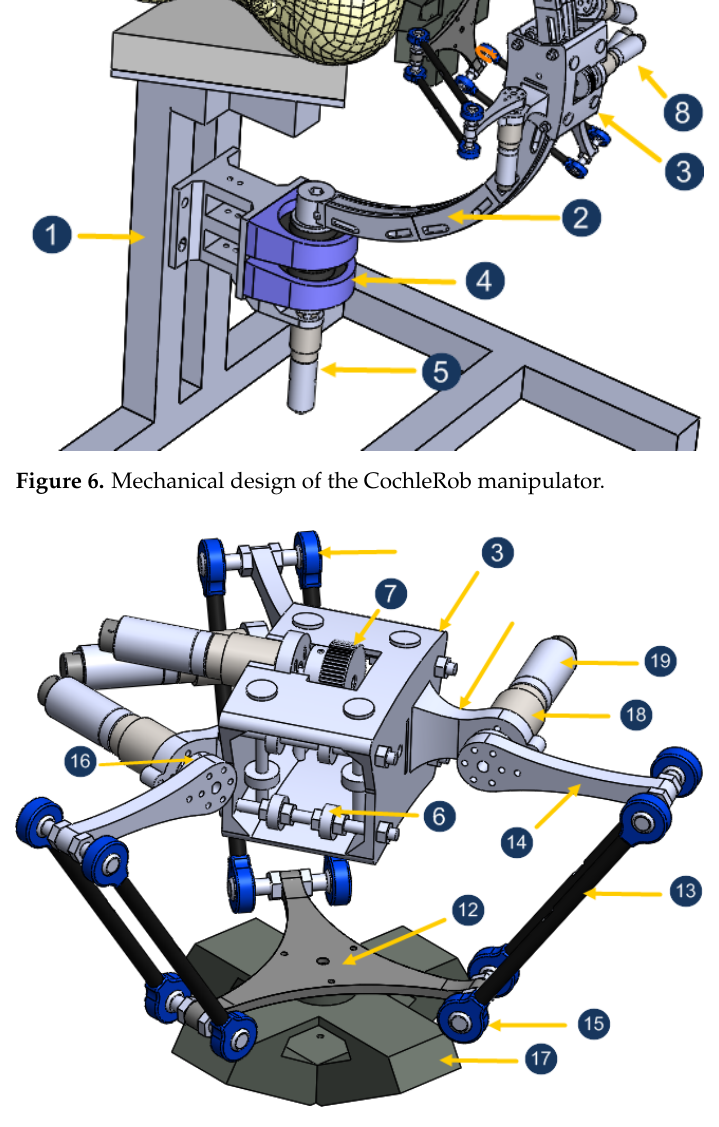
Figure 7. The parallel